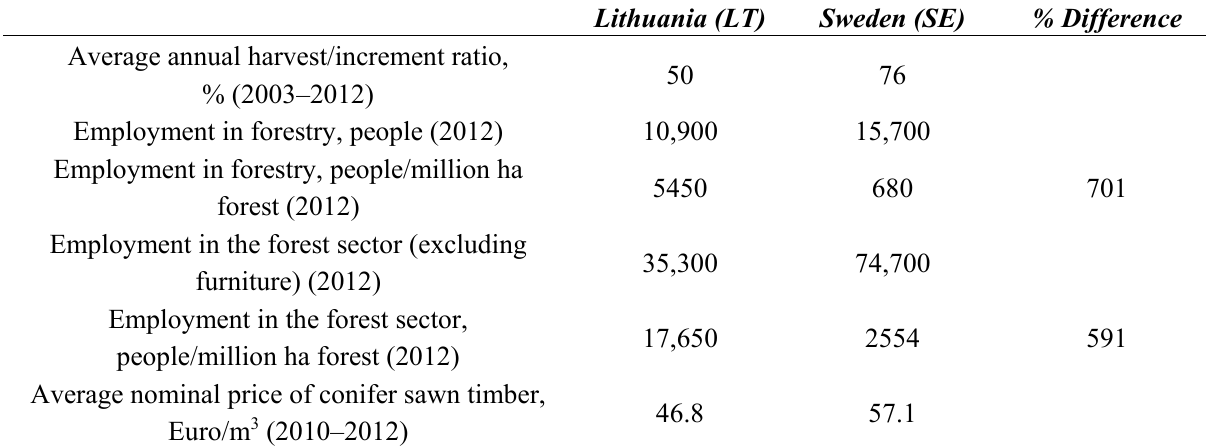
Table 1. Selected indicators of Lithuanian and Swedish forest